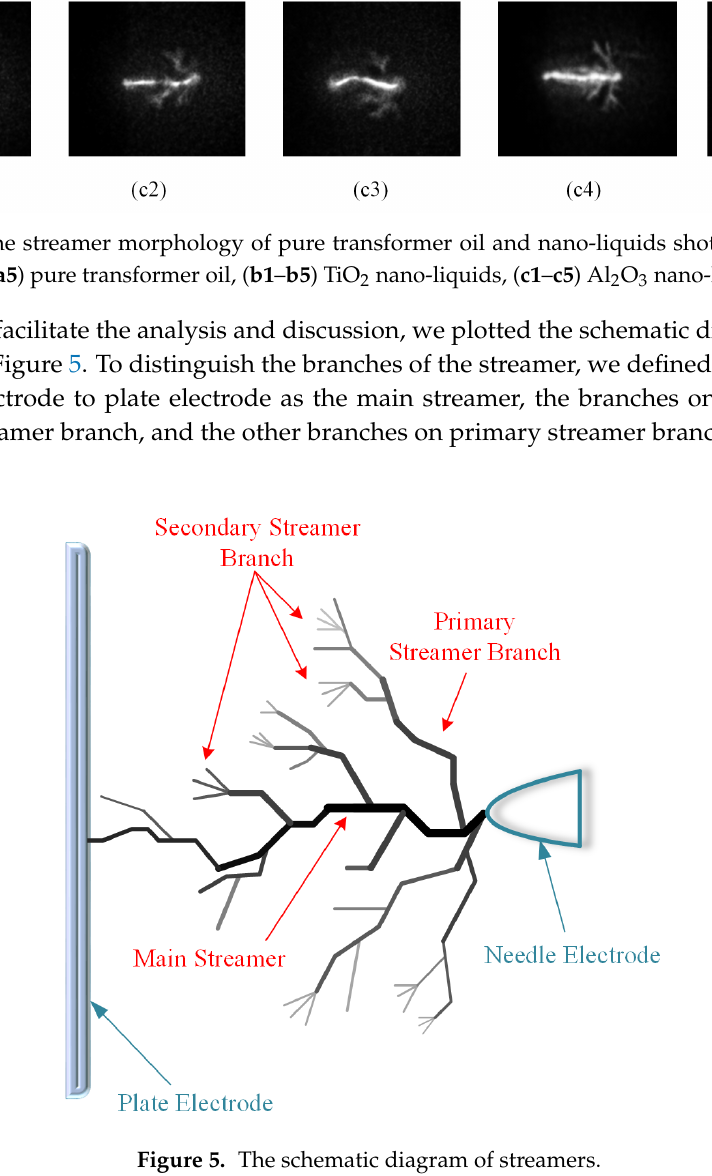
Figure 5. The schematic diagram of